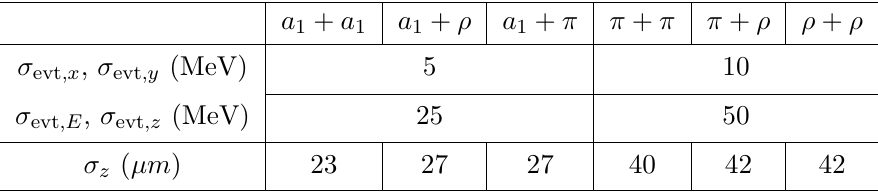
Table 2 . The optimized resolutions for the resolution parameters that enter eq. (2.4) in di(cid:11)erent (cid:28) + (cid:28) (cid:0) decay